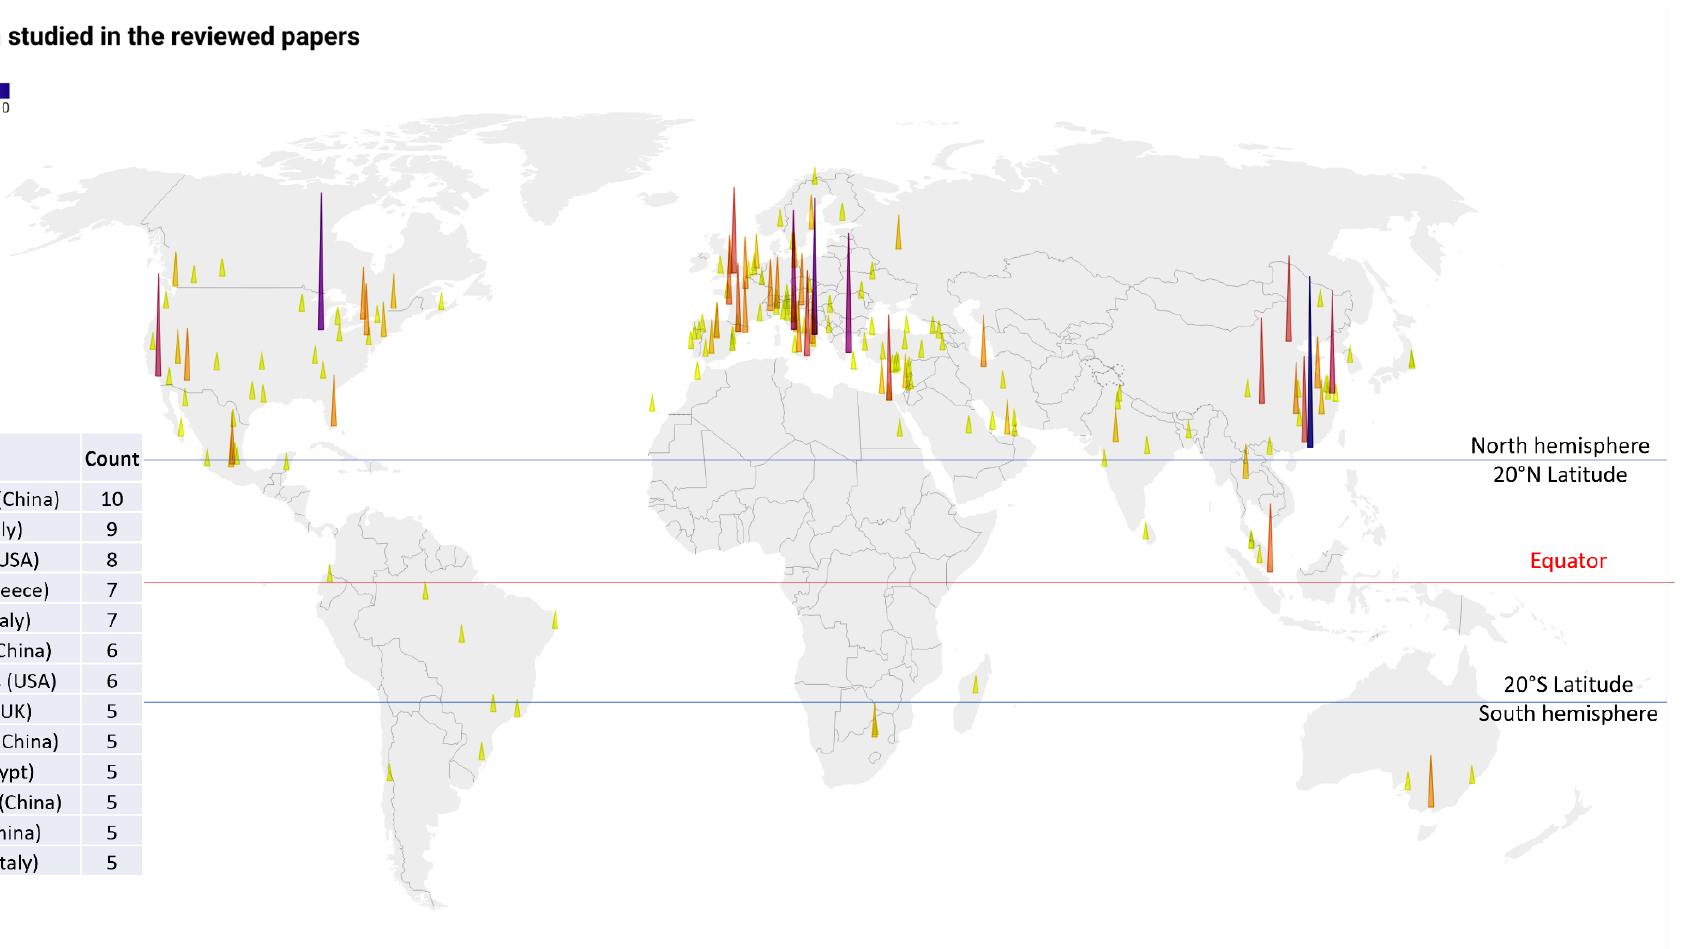
Figure 7. A world map illustrating the distribution of the studied cities in the reviewed papers. Map edited using Datawrapper website. Available online: https://www.datawrapper.de/ (accessed on 7 May 2022).